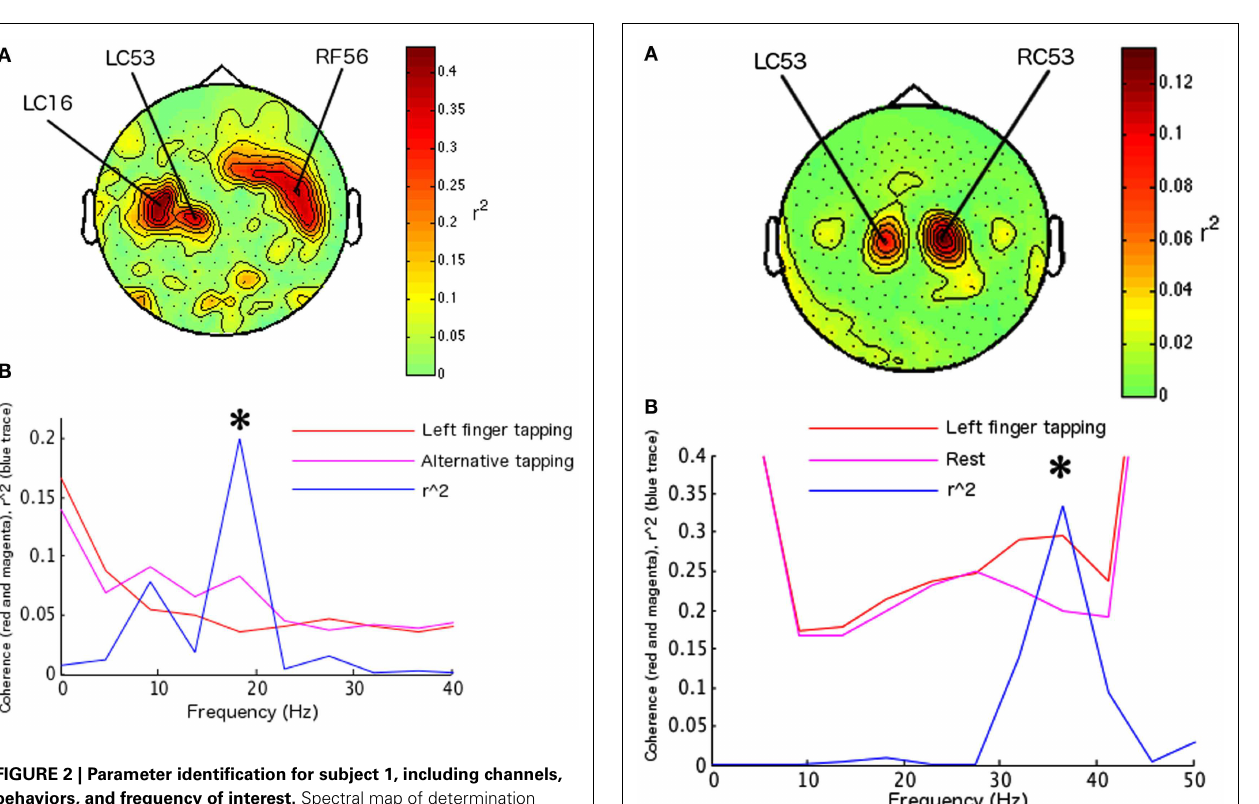
FIGURE 2 | Parameter identification for subject 1, including channels, behaviors, and frequency of interest. Spectral map of determination coefficients ( r 2 values) between left and right hand movements (as in Mellinger et al., 2007) across frequencies and channels were used to identify an SMR-related frequency. (A) Topographical map of determination coefficients between left hand versus right hand movements at the frequency used to identify SMR-related sensors; this was the frequency of interest during coherence feedback for this participant.The location of extreme determination coefficients is in accord with spatial localization of the SMR, that is, over sensorimotor cortex (Kuhlman, 1978). (B) Plot of the largest regression values for subject 1 during behavior identification, indicating the frequencies at which the difference in coherence between the behaviors of interest was largest. Left index finger tapping versus bimanual alternate tapping elicited the largest determination coefficient (determination coefficients for other behavior pairs not shown).These behaviors were used to control real-time coherence. Asterisks indicate statistical significance at frequencies of interest for on-line feedback.